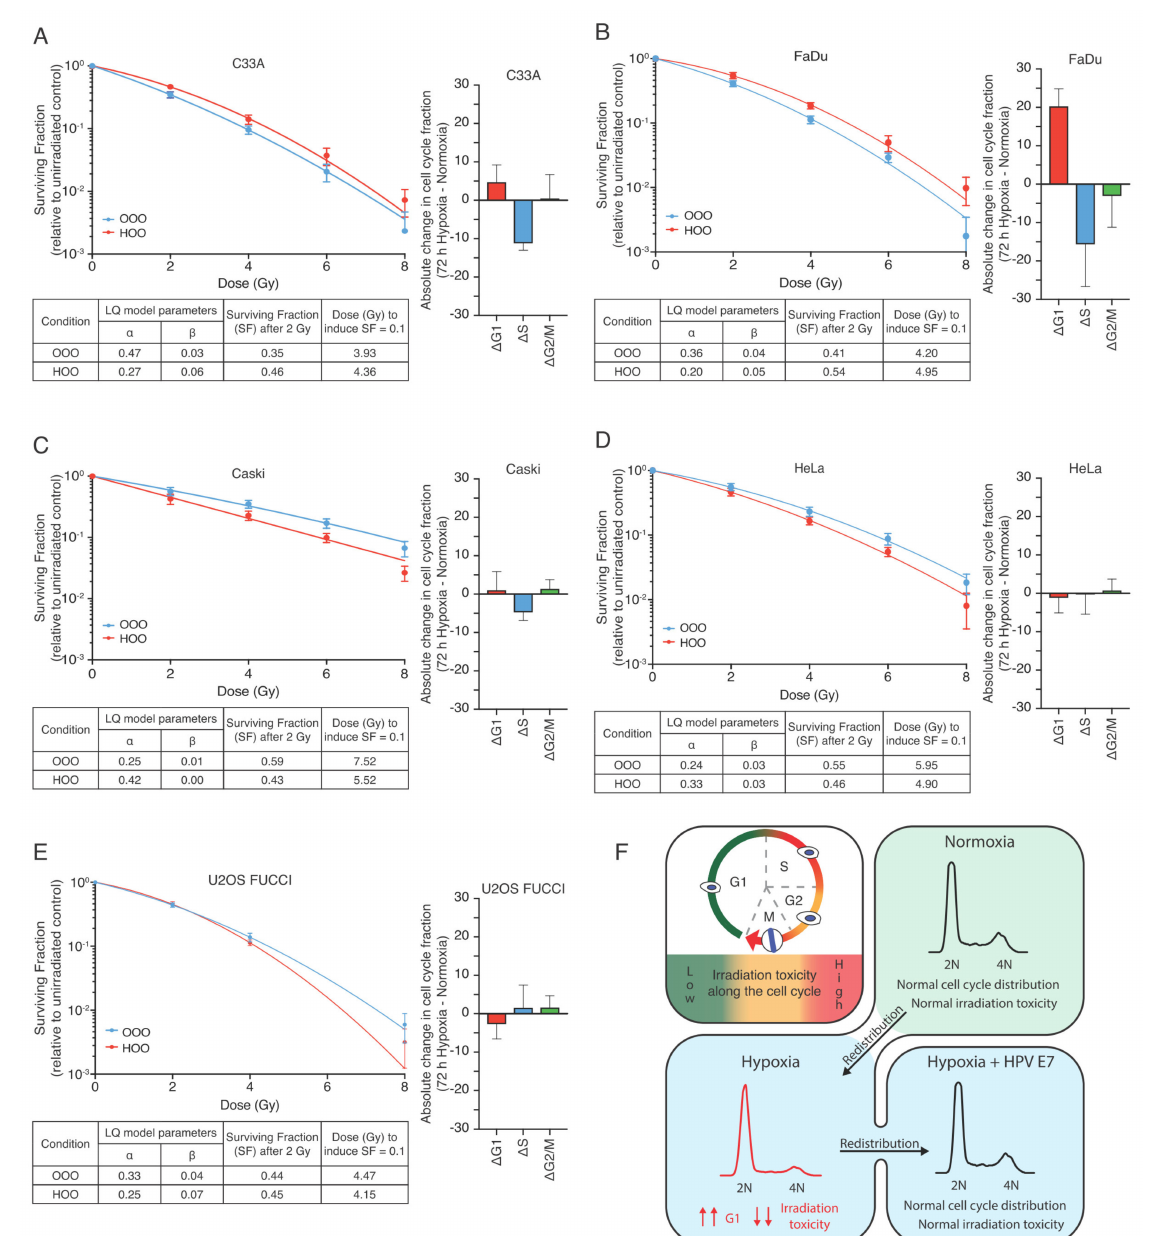
Figure 5. Hypoxia-induced G1-arrest determines radioresistance upon reoxygenation in tumor cell lines and it is governed by the HPV status: ( A – B ) Difference of each cell cycle phase fraction between hypoxic and normoxic cell cycle distribution ( ∆ cell cycle population fraction) along with colony-forming assay of HPV-negative C33A ( A ) and FaDu ( B ). Cells were irradiated with graded single doses of irradiation after being either constantly under normoxic conditions (blue curve— OOO) or for 72 h in hypoxia (1% O 2 ) and subsequently irradiated in aerated condition (red curve—HOO). ( C – D ) Difference of each cell cycle phase fraction between hypoxic and normoxic cell cycle distribution ( ∆ cell cycle population fraction) along with colony-forming assay of HPV-positive Caski ( C ) and Hela ( D ) cells Similar conditions as in ( A – B ). ( E ) Difference of each cell cycle phase fraction between hypoxic and normoxic cell cycle distribution ( ∆ cell cycle population fraction) along with colony-forming assay of HPV-negative U2OS cells that exhibit an aberrant G1/S transition. Cells were irradiated after being either constantly under normoxic conditions (blue curve—OOO), for 72 h in hypoxia (1% O 2 ) and subsequently irradiated in aerated condition (red curve—HOO) or for 72 h in hypoxia (1% O 2 )and also irradiated under hypoxic conditions (green curve—HHO). The parameters of the Linear Quadratic model (LQ) of the survival curves are shown collectively for all conditions in separate tables. ( F ) Graphical representation of our working model depicting the main findings of the